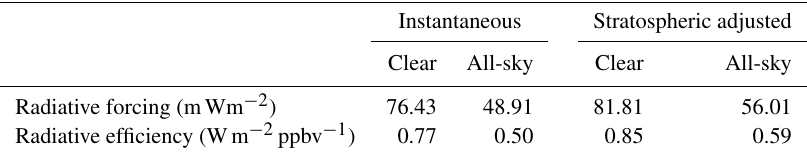
Table 5. Calculated instantaneous and stratospheric adjusted radiative forcings and radiative efficiencies of SF 6 in clear and all-sky conditions. ∗